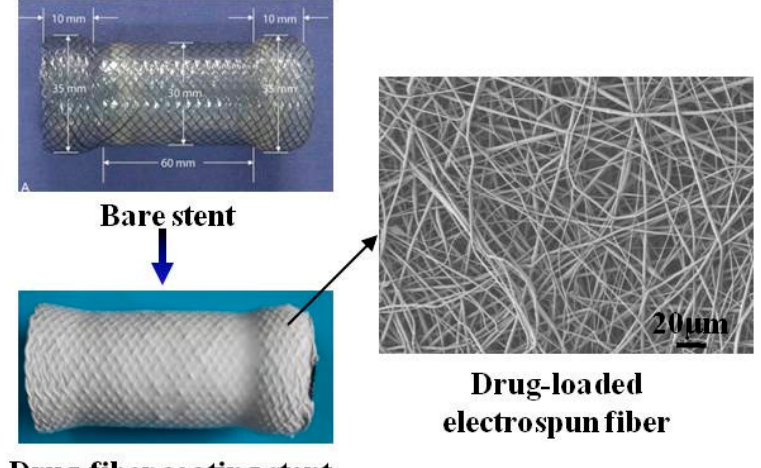
Figure 8. Fabrication stent coated with electrospun PCL fibrous membrane containing paclitaxel by fixing a bare stent on the rotor as the collecting setup for the treatment of benign cardia stricture [86]. Copyright permission from Elsevier.